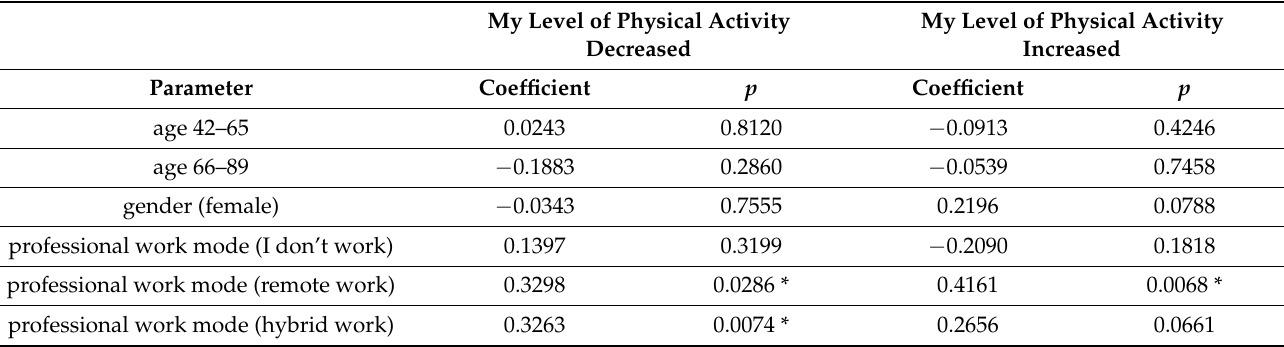
Table 5. Multivariate linear regression analysis of the association between age, gender, professional work mode, and the effect of pandemic COVID-19 on the physical activity change.